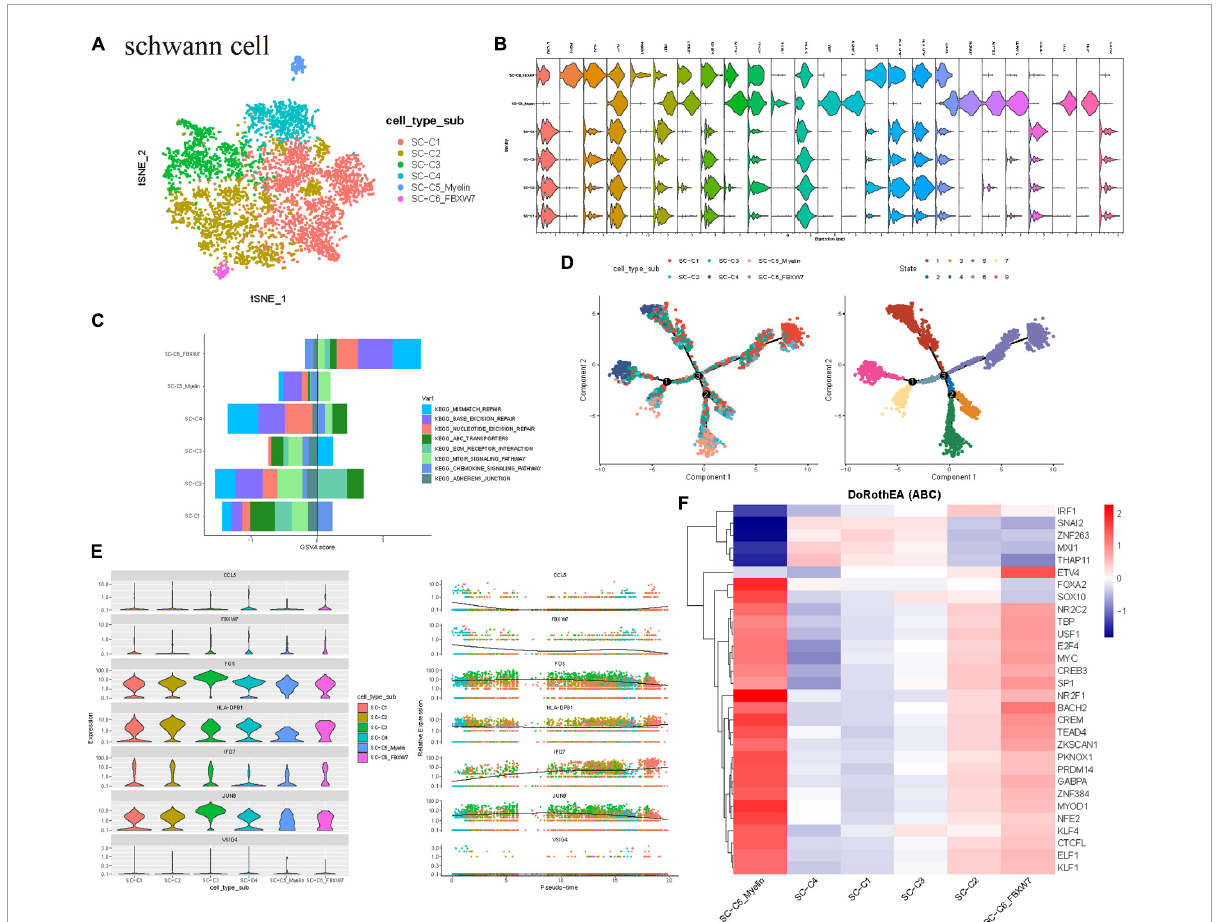
FIGURE2 Schwann cell population heterogeneity in sporadic acoustic neuroma. (A) TSNE diagram showing Schwann cell subsets. Different cell types are indicated by different colors. (B) Violin plots showed the scaled expression levels of canonically cell marker genes used to identify each cell types. (C) The histogram shows GSVA score of the first 8 KEGG enrichment pathways. (D) All SCs ordered along pseudotime trajectories, with the cells color-coded by cluster. (E,C) Subtypes. The left dendrogram was calculated using all differential genes and is colored according to group membership. (E) Scatter plots depicting scores for the indicated upstream regulators for each cell across pseudotime. X axis, cell subset; Y axis, Relative Expression. (F) Heatmap of top 50 highly variable TF activities among the Schwann cell subsets; the z-scores of TF activities are